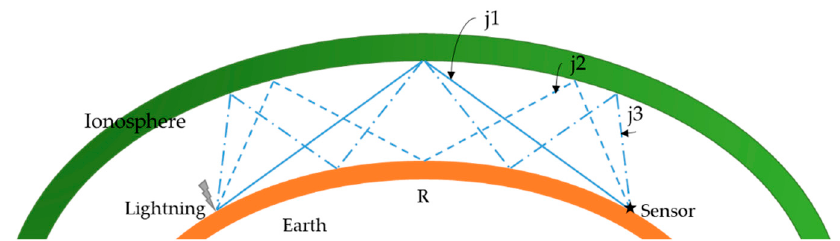
Figure 6. Schematic representation of VLF lightning propagation in the Earth-ionosphere. The pentagram represents a lightning detection site.